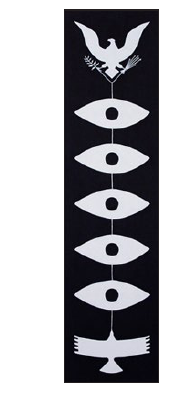
Figure 2: ‘Five Eyes Network, 2014’ (image credit: John G. Johnston)